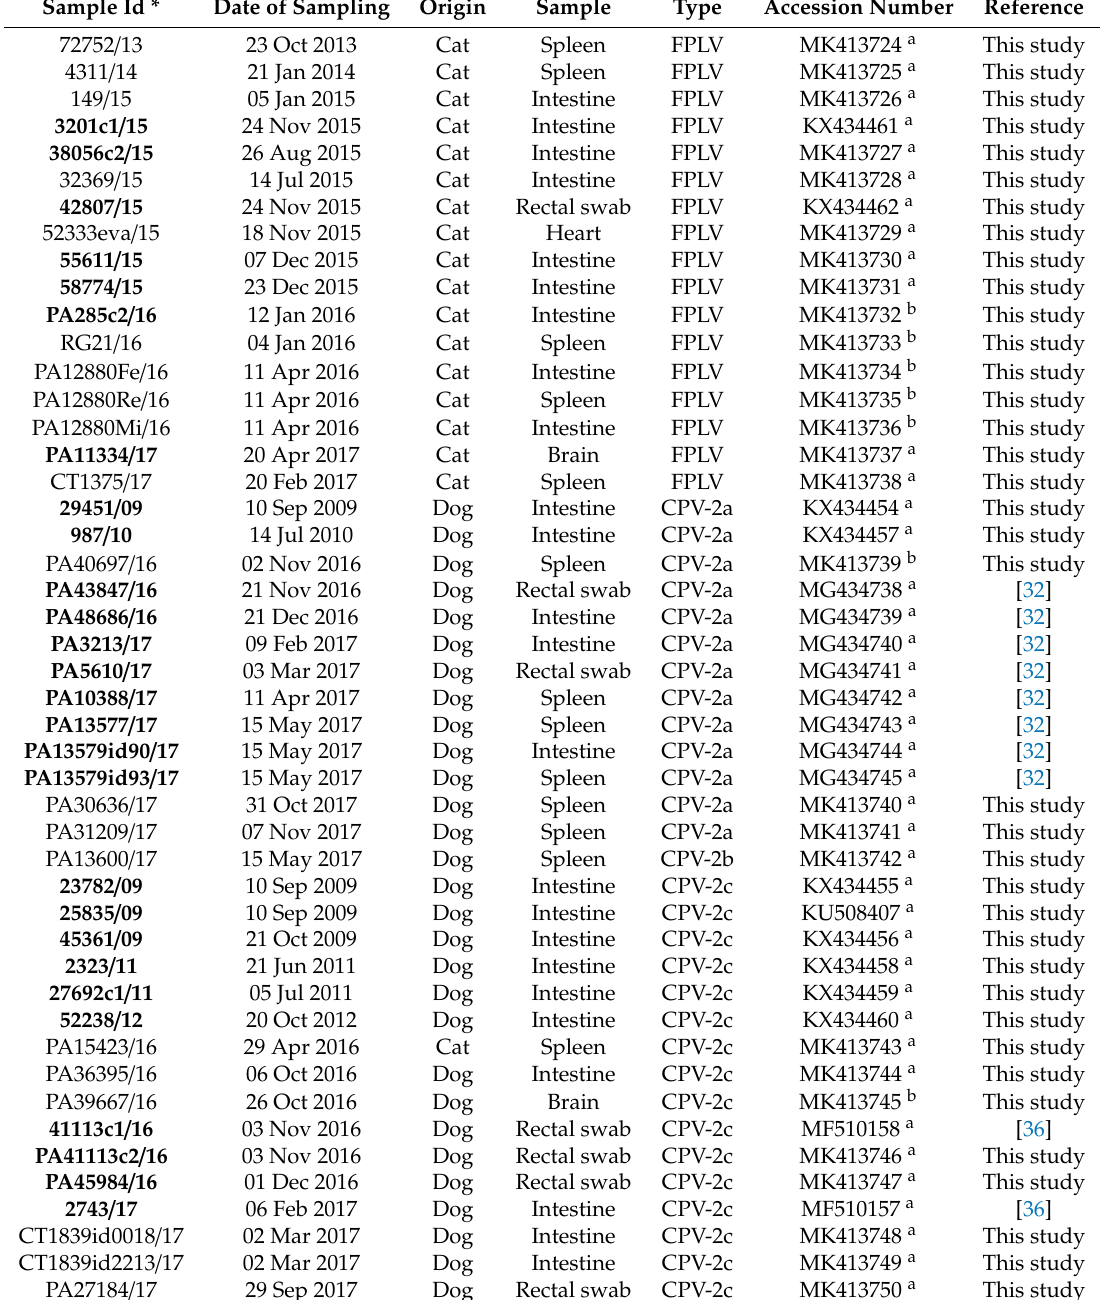
Table 1. Origin and information on samples of cats and dogs. FPLV—feline panleukopenia virus; CPV—canine